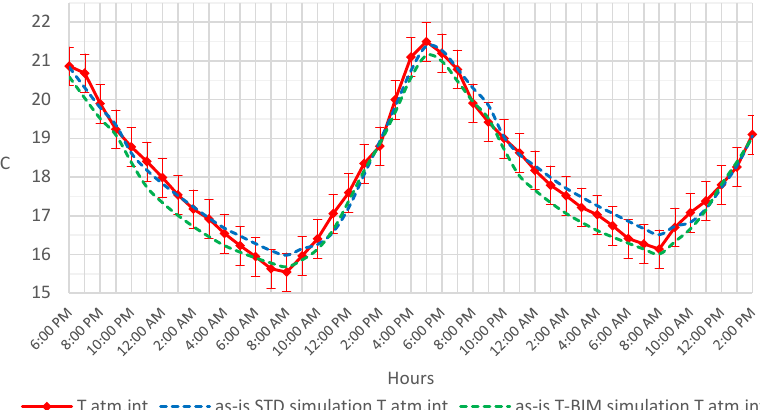
Figure 10. Average simulation and monitored surface temperatures of the wall and floor of Room W1, 18, 19, and 20 November 2021.